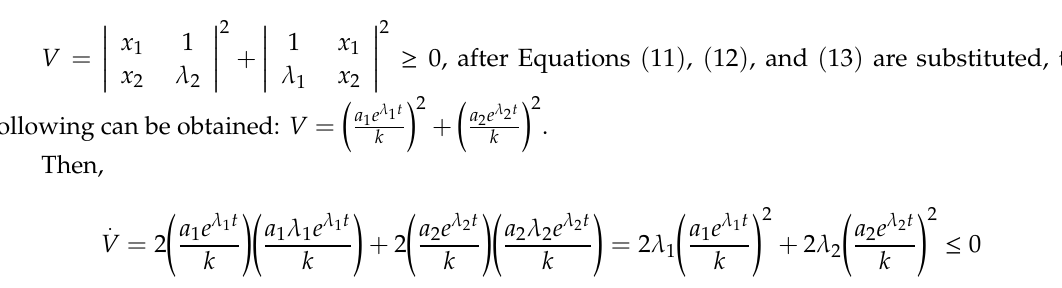
Figure 9. Phase diagram of system with known parameters (with disturbance, λ 1 = − 1, λ 2 = −